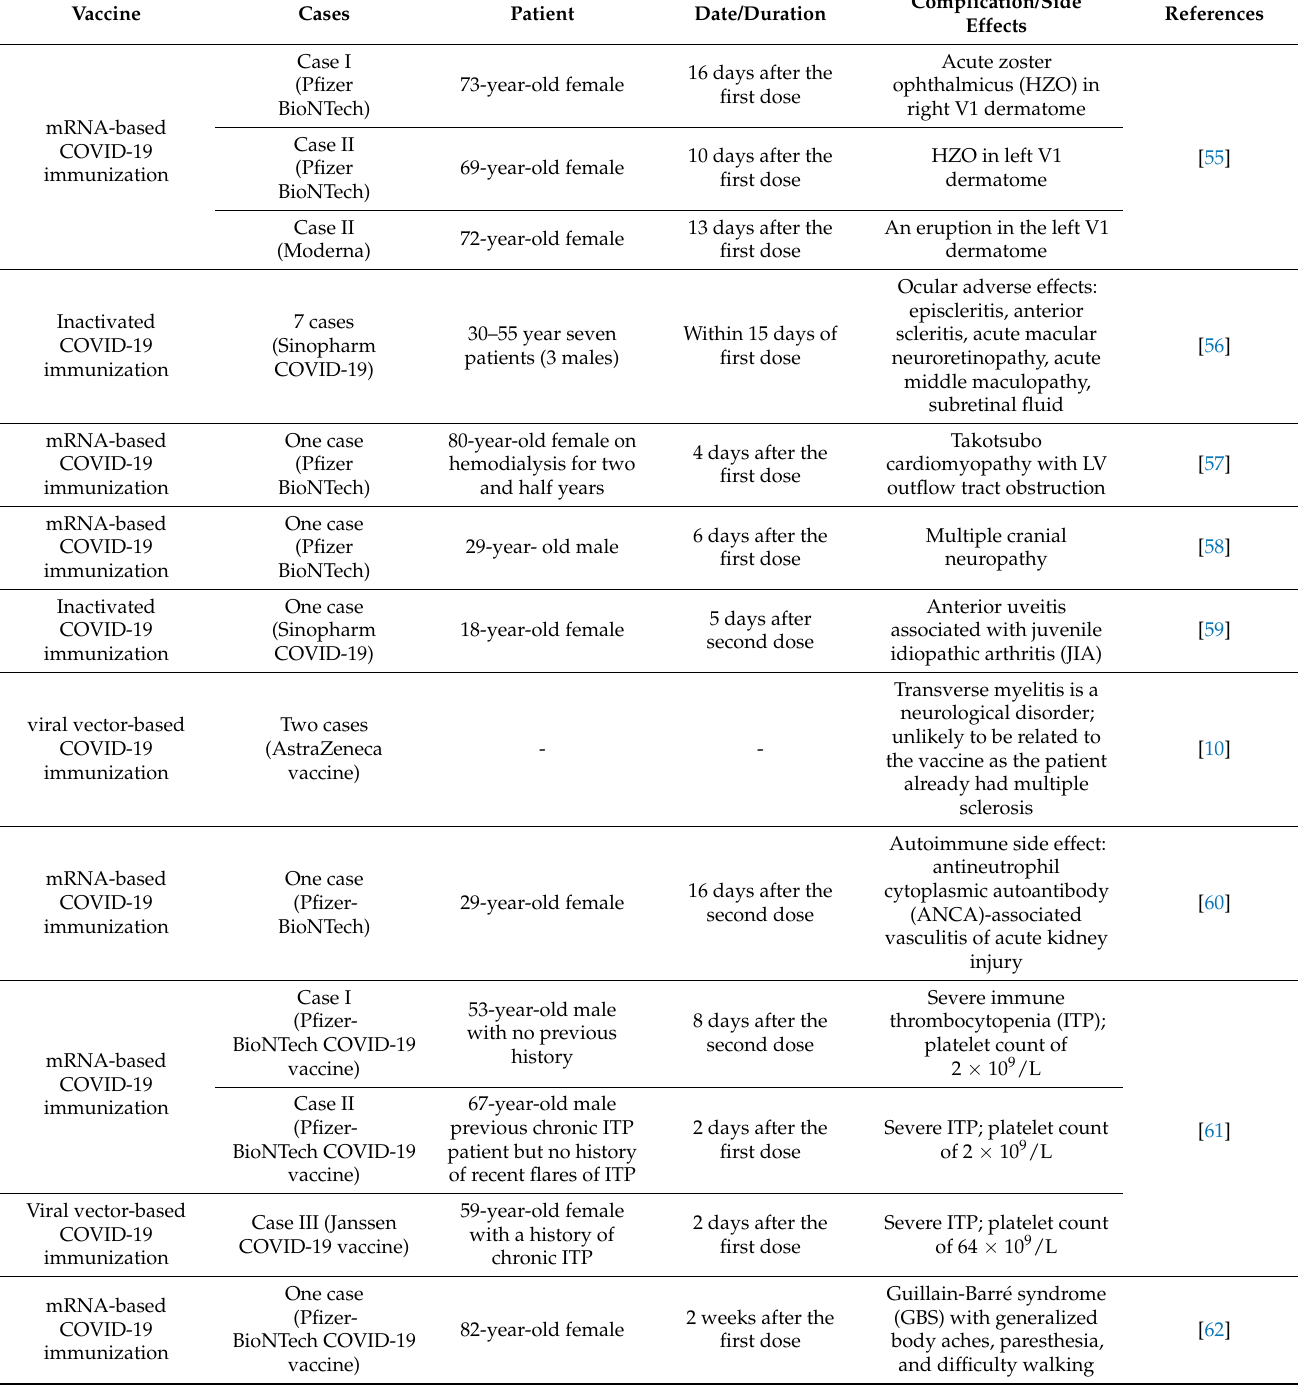
Table 3. Case studies with reported SEs of COVID-19